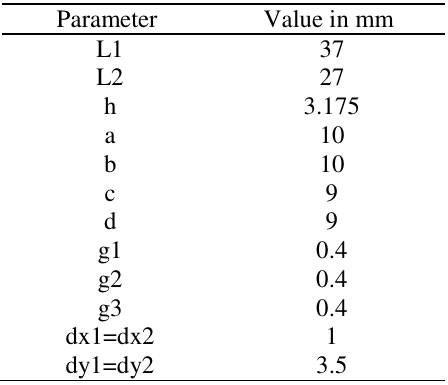
Table 1: This is an example of a table.